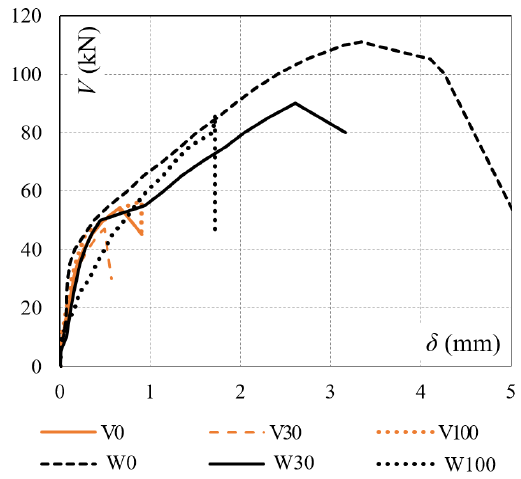
Figure 6 – V - δ response of the tested